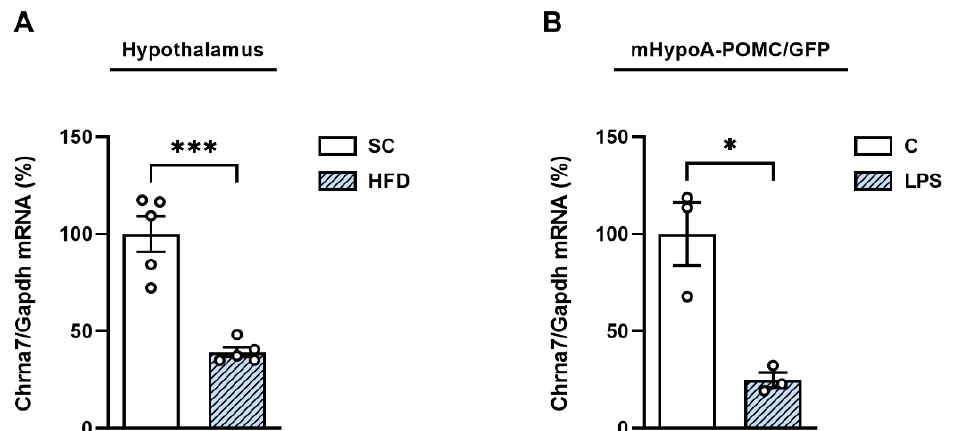
Figure 1. Short-term high-fat diet and LPS reduce Chrna7 expression in mice hypothalamus and hypothalamic neurons. ( A ) RT-qPCR analysis of α 7nAchR expression levels in the hypothalamus of C57BL/6J mice fed with HFD (60%) or standard chow (SC) for 3 days and ( B ) in mHypoA- POMC/GFP immortalized hypothalamic neurons treated with LPS (100 ng/mL) for 3 h. * p < 0.05, *** p < 0.001, n = 5-3.